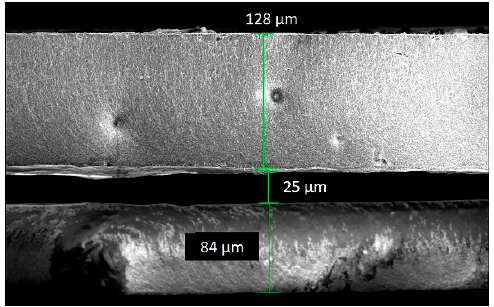
Figure 2. Microstructure of a kerf created by the release of the graphite foil during the post anneal step.